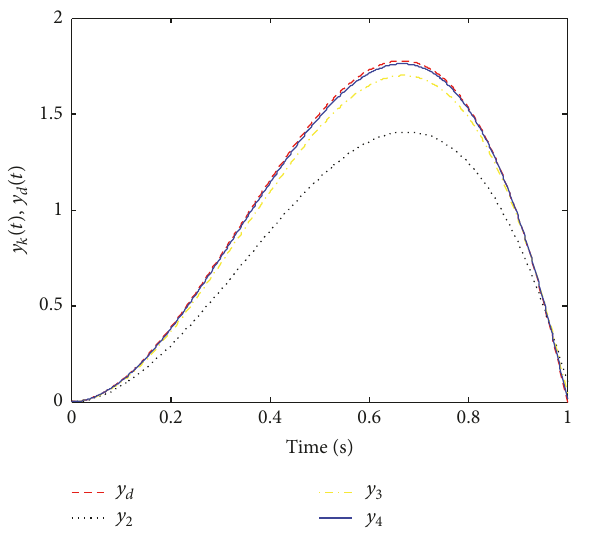
Figure 1: System outputs of (𝐼 1 ) .